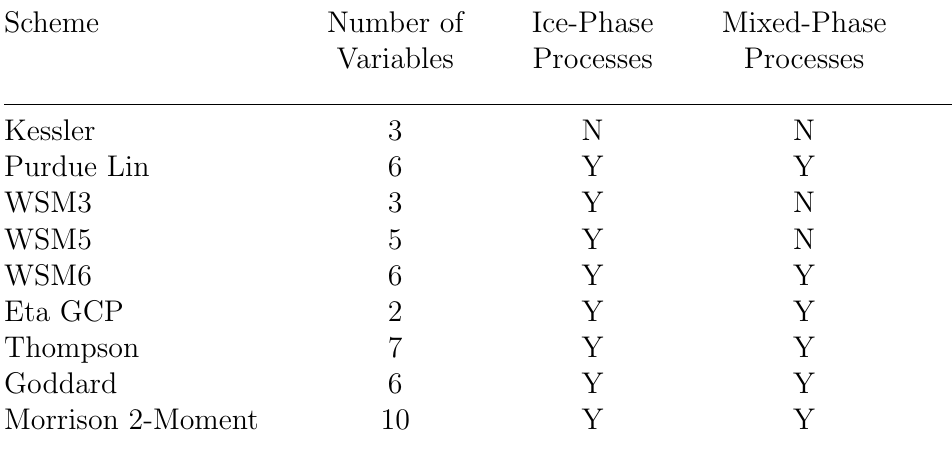
Table 8.1: Microphysics